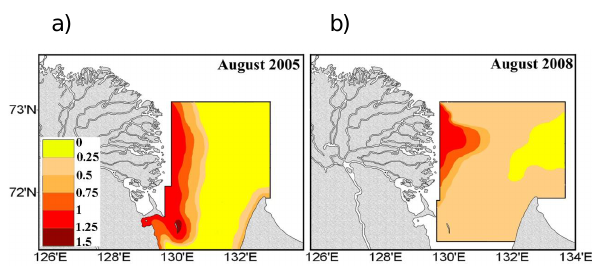
Fig. 6. Distribution of particular organic carbon in the Buor-Khaya Bay surface water layer in August 2005 (a) and August 2008 (b) . Concentration range (mgL − 1 ) is shown as colored rectangles in (a) .